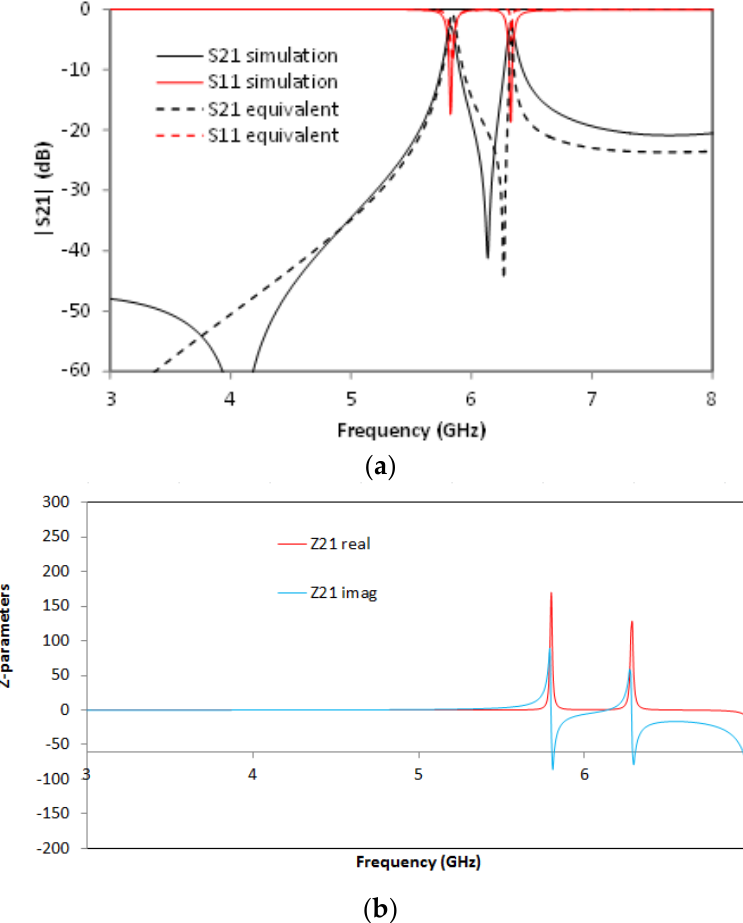
Figure 21. ( a ) Simulated S21 (solid black line), simulated S21 for the equivalent circuit model (dashed black line), simulated S11 (solid red line), simulated S11 for the equivalent circuit model (dashed red line). ( b ) Impedance graph: Z21 real part (solid red line), Z21 imaginary part (solid blue line).